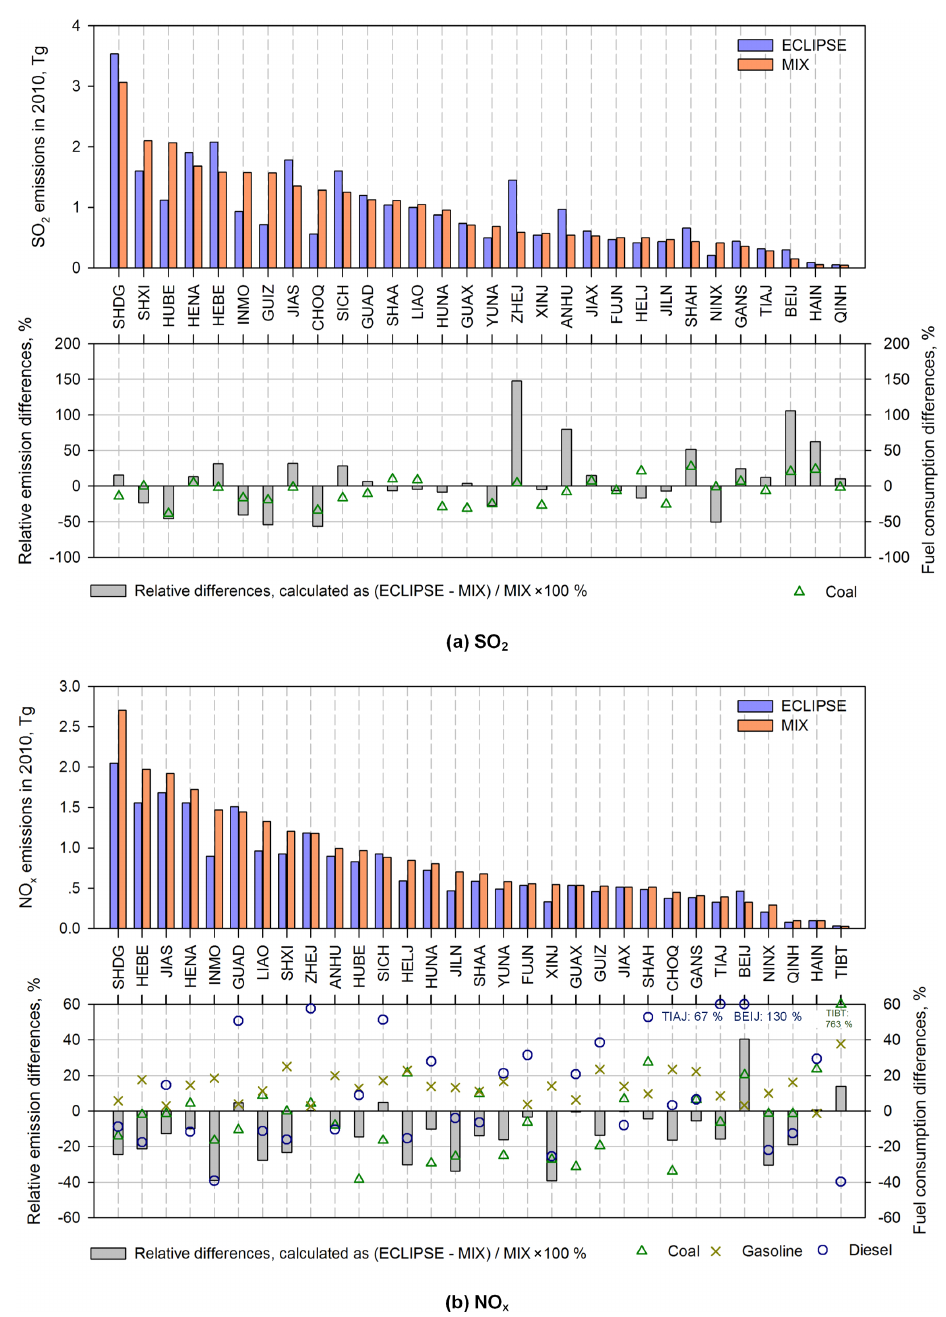
Figure 2. Comparisons of emission estimates and fuel consumption by province in China in 2010. Values out of y axis range are labeled separately in the graphs. Abbreviations of provinces are provided in Table